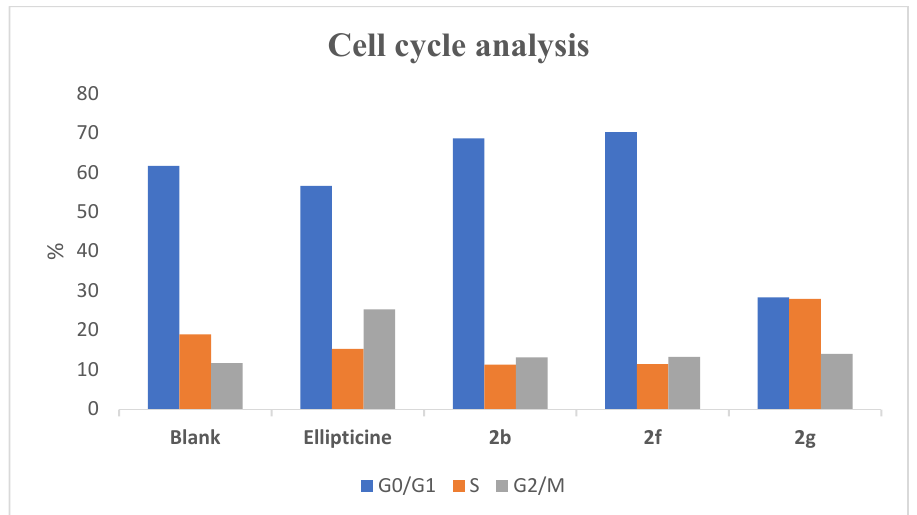
Figure 1. Effects of compounds 2b , 2f , and 2g on AGS cell cycle profile at their GI 50 concentrations. Compounds 2b and 2f caused cell cycle arrest in G0/G1 phases, although this result was not statistically significant (Qi2 test). On the other hand, for the G2/M phase, these compounds did not present any difference in the percentage of cells compared to the blank. In Figure 2, histograms of the AGS cell cycle profile for blank and compound 2f are presented. Compound 2b presented a similar histogram to the one obtained for the blank, and compound 2g caused a high percentage of cell death and an atypical distribution on cell cycle profile (results not shown).